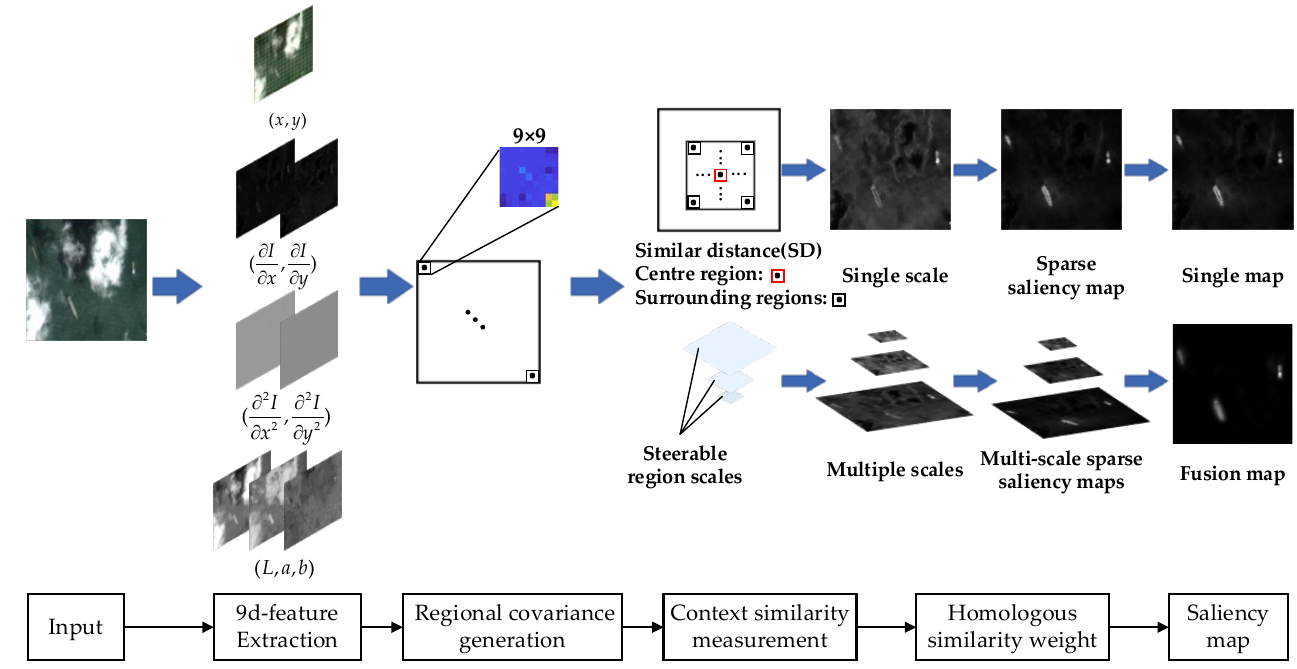
Figure 3. The proposed workflow based on the saliency model.